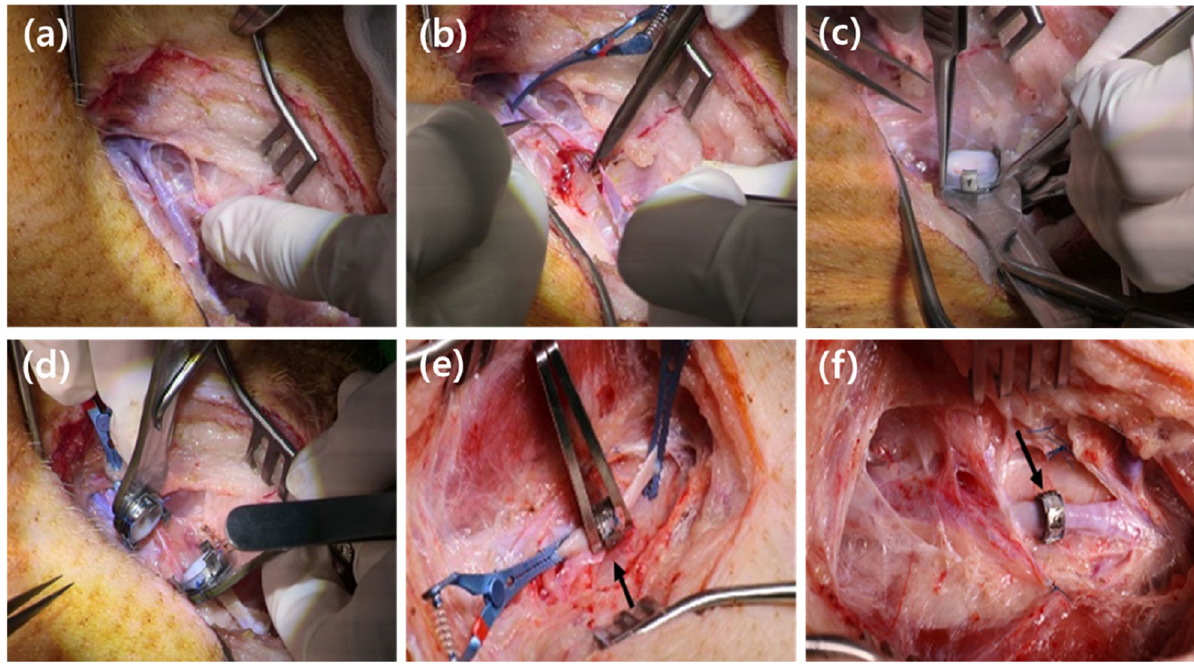
Figure 3. Sequential intraoperative photographs of the jugular vein anastomosis using titanium vascular anastomotic device (TVAD). ( a ) A longitudinal neck incision was made, and the external jugular veins in the neck were exposed. ( b ) After clamping both sides of the most cephalic and caudal areas of the exposed jugular vein, the blood vessel was vertically cut at the midpoint and divided. ( c ) One vessel is inserted into the